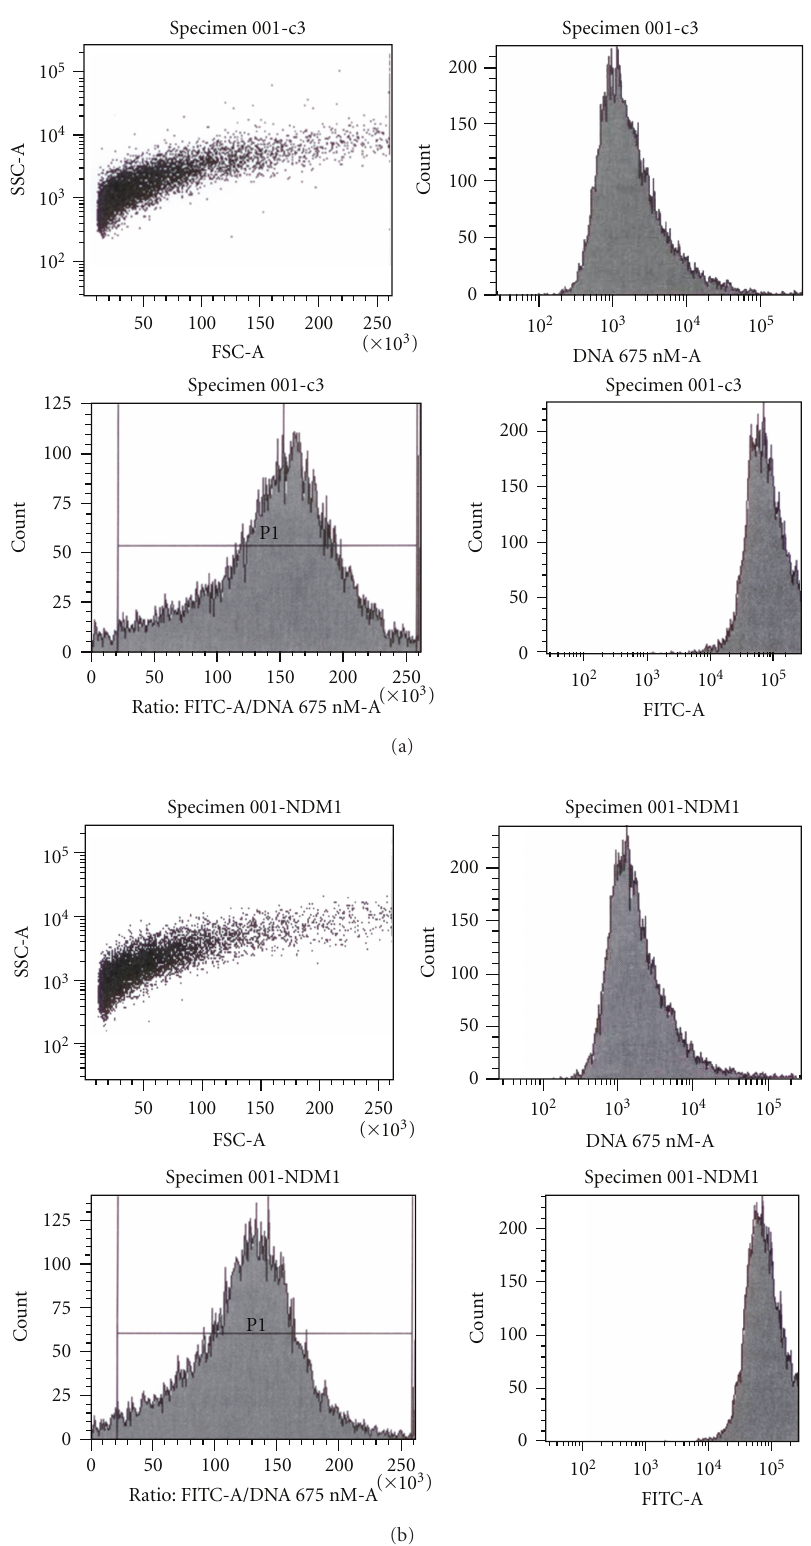
Figure 5: (a) S. gordonii (control) stained with Live/Dead Bac Light and analyzed by flow cytometry. (b) S. gordonii (NDM treated) stained with Live/Dead Bac Light and analyzed by flow